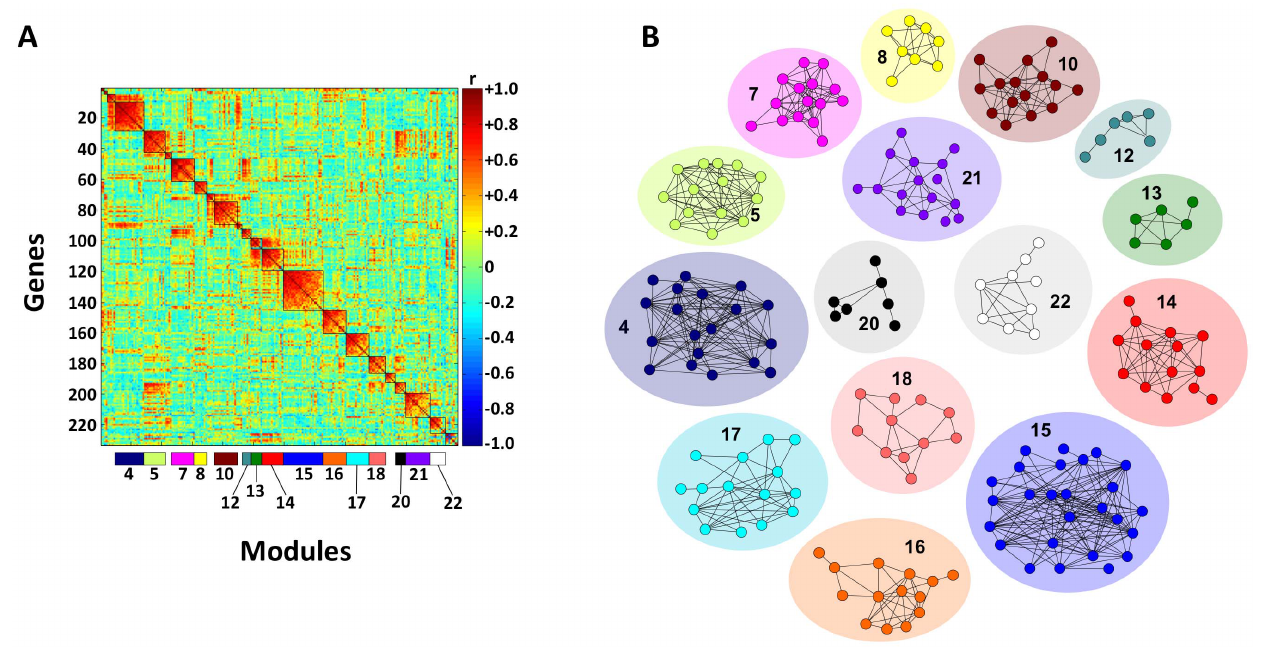
Figure 3. Modulated modularity clustering (MMC) heat map revealing modules of genes that covary in expression and relevance networks for genes within the modules. (A) MMC analysis of transcript expression levels for the top 233 genes identifying 23 gene modules. (B) Relevance networks for genes correlated within MMC modules obtained by enforcing an absolute correlation threshold of |r| $ 0.6. Only networks containing 5 or more genes are depicted. Color-coding of the relevance networks by gene module corresponds to that shown in the horizontal bar under the heat map in ( A ).